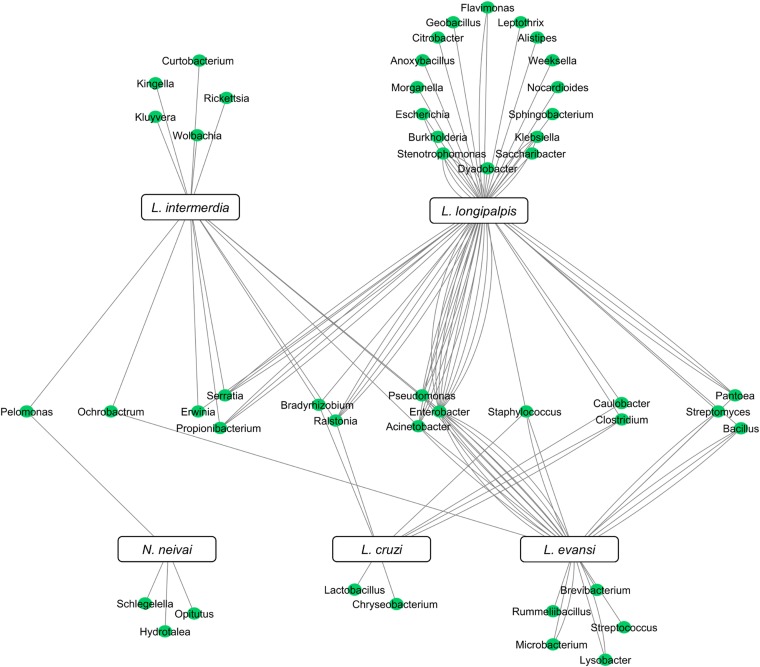
New World field sand flies microbiota. Network analysis showing bacteria genera found in L. intermedia, L. longipalpis, L. evansi, L. cruzi, and N. neivai (syn. L. neivai) obtained exclusively from field collection studies. References used: Oliveira et al. (2000); Gouveia et al. (2008); McCarthy et al. (2011); Sant'Anna et al. (2012); Machado et al. (2014); Monteiro et al. (2016); and Vivero et al. (2016).